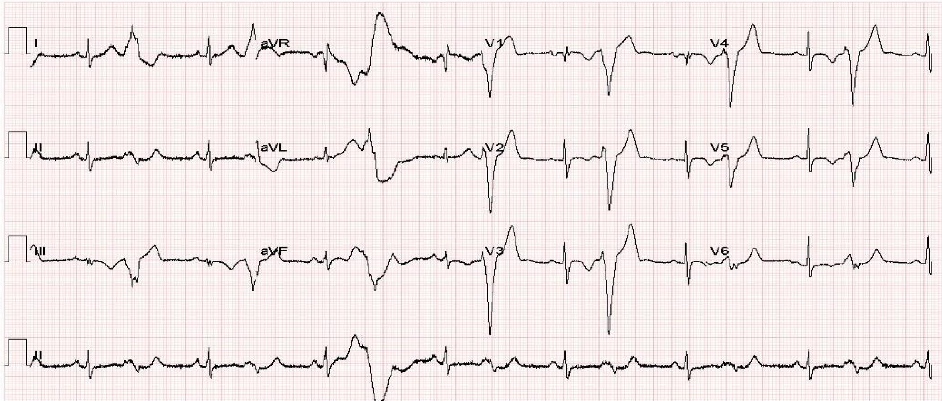
Figure 5. Sample COVID-19 ECG trace image from the dataset, the time is represented by the horizontal axis; each time step lasts 0.04 s and is indicated by a vertical line. The vertical axis shows signal magnitudes in millivolts. Table 2. Datasets details.